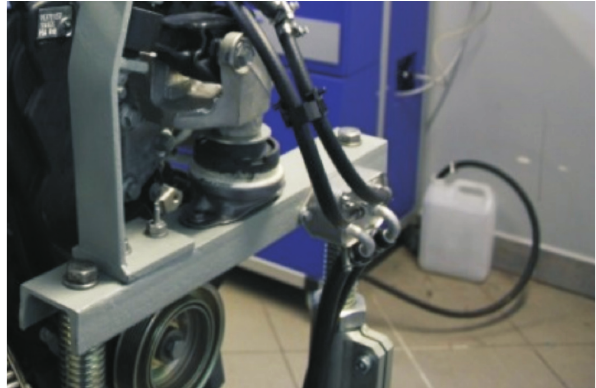
Fig. 7. Dynamometer test bed with the PSA DW10 engine for the evalu - ation of fuel injector contamination according to the CEC F-98-08 test